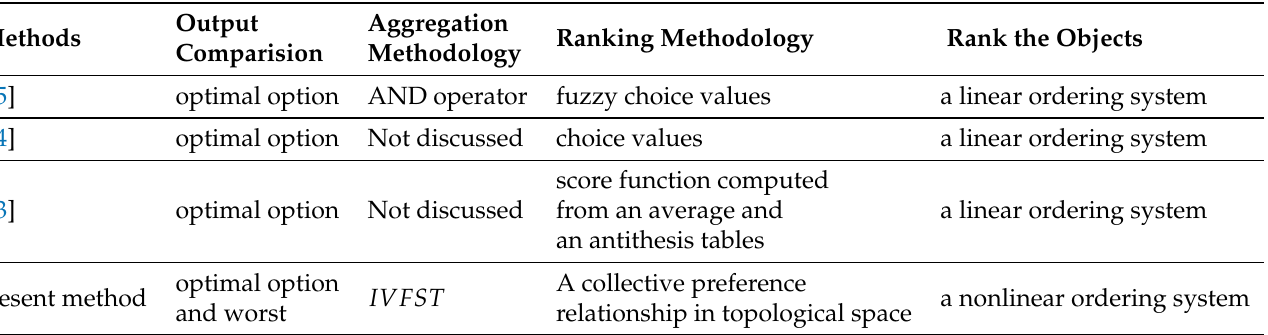
Table 11. Comparison of Existing